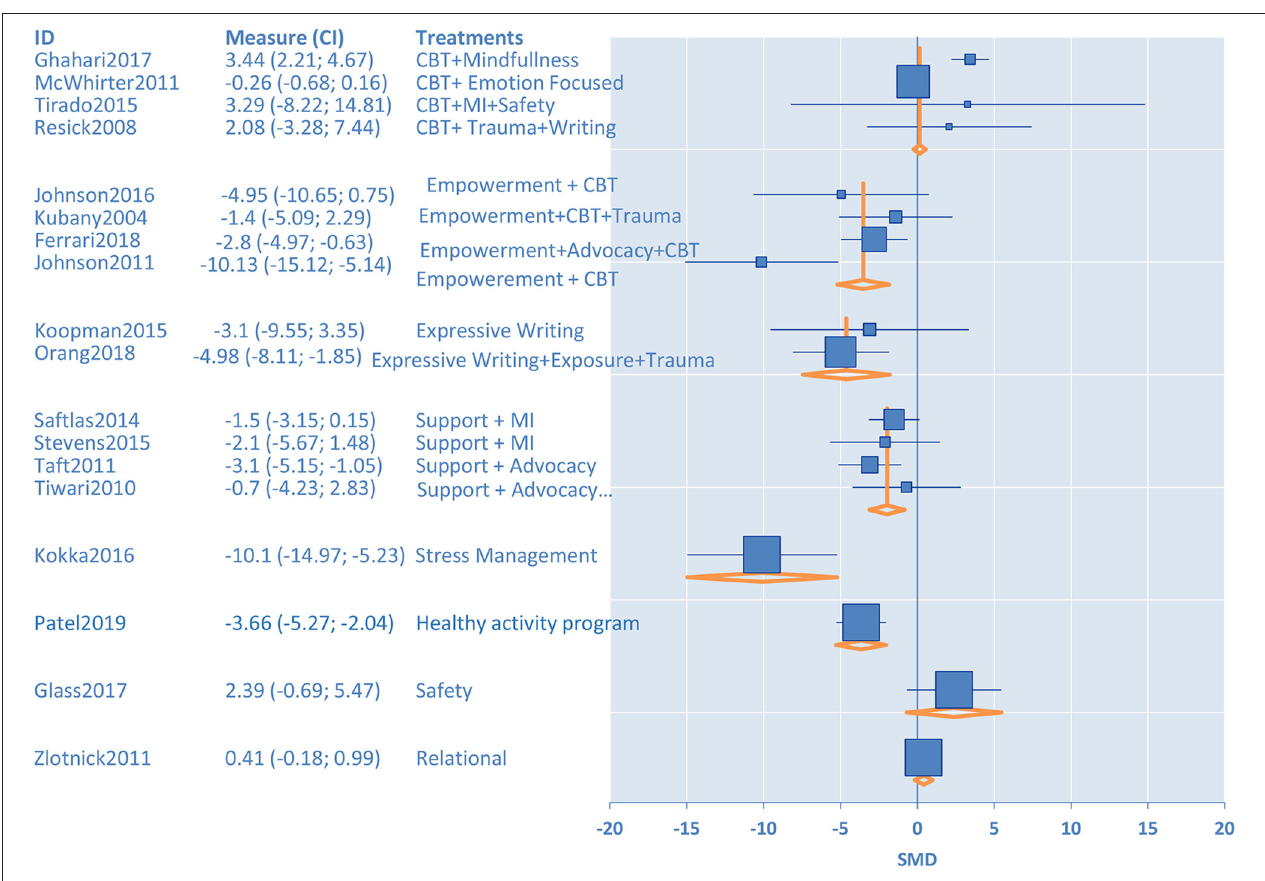
FIGURE 4 | Subgroup analysis for treatment of depression for female victims of intimate partner